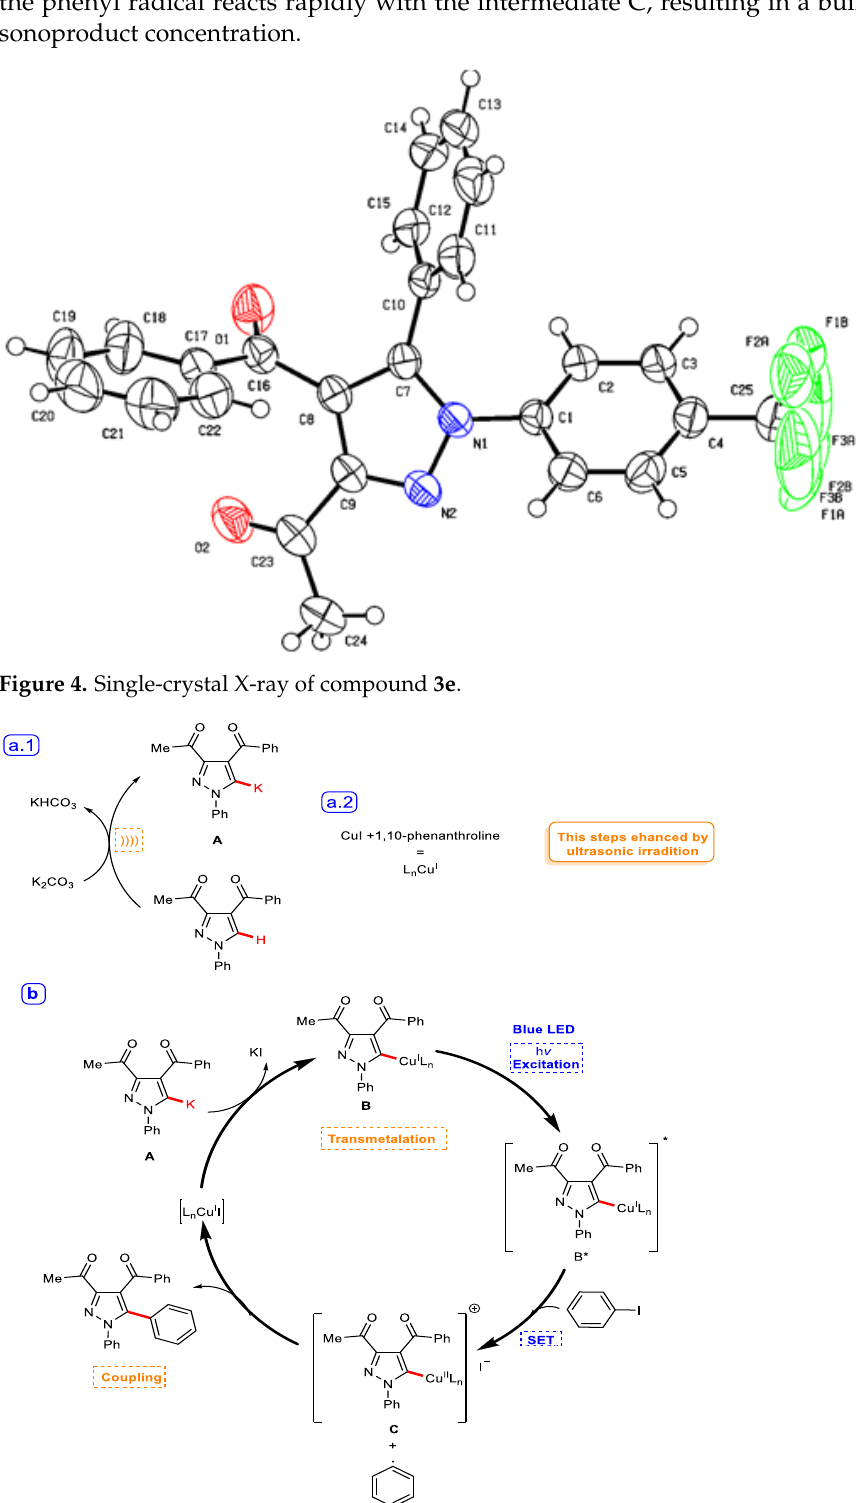
Figure 3. Single-crystal X-ray of compound 3c .